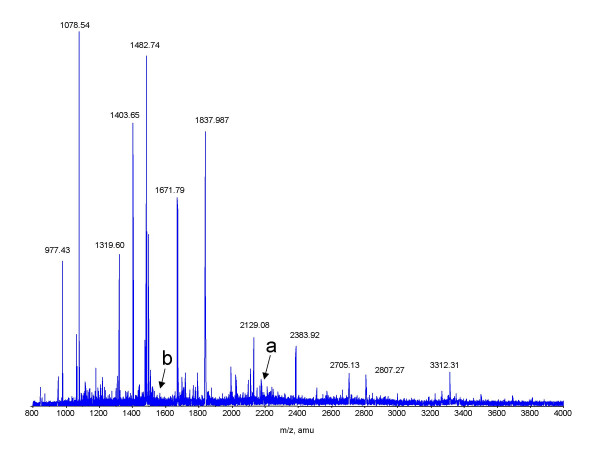
MALDI-qTOF MS analysis of E1 tryptic digest. Protein characterization by peptide mass fingerprinting allowed for over 50% sequence coverage of the E1 phosphoprotein. Letters "a" and "b" indicate two peaks of low signal intensity corresponding to the phosphopeptides LDLIDEEEDpSEEDGDSMR and VLpTPLQVQGEGEGR, respectively.